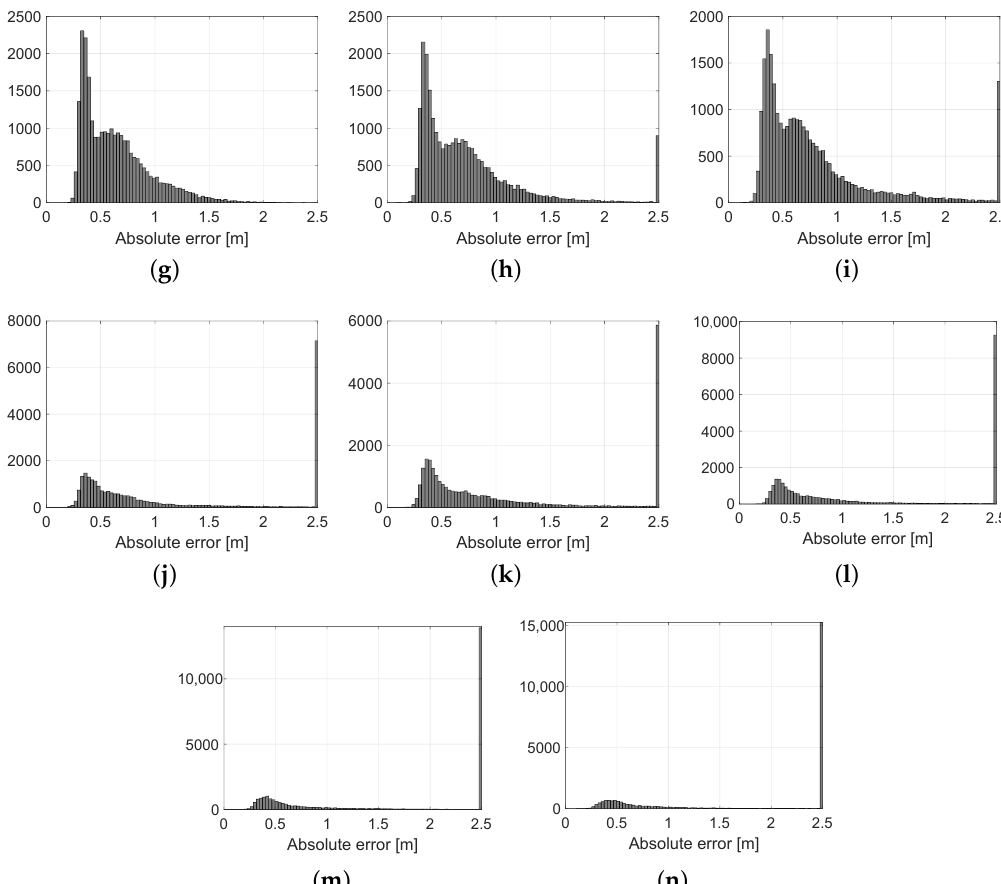
Figure 12. Histograms of the pose tracking localization error for different decimation ratios. Note that errors larger than 2.5 m are clipped into one single bin for the largest decimation ratios, for the sake of providing a uniform horizontal scale in all plots. ( a ) Decimation = 20; ( b ) Decimation = 40; ( c ) Decimation = 60; ( d ) Decimation = 80; ( e ) Decimation = 100; ( f ) Decimation = 150; ( g ) Decimation = 200; ( h ) Decimation = 300; ( i ) Decimation = 500; ( j ) Decimation = 700; ( k ) Decimation = 800; ( l ) Decimation = 1000; ( m ) Decimation = 1500; ( n ) Decimation = 2000.